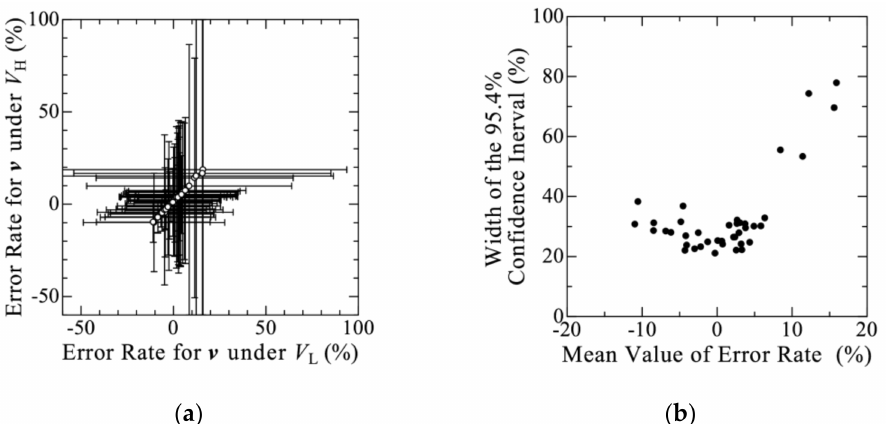
Figure 11. ( a ) Mutual relationship between the estimation accuracies of the electric field distribution estimated for the space charge waveforms, v , obtained for V L = 30 kV and V H = 45 kV. Each plot represents the accuracy evaluation results for the different 81 IRs. The error bars represent the width of a 95.4% confidence interval. The relationship between the mean and the confidence interval of the error rate under the V L condition was reproduced in ( b ) to increase